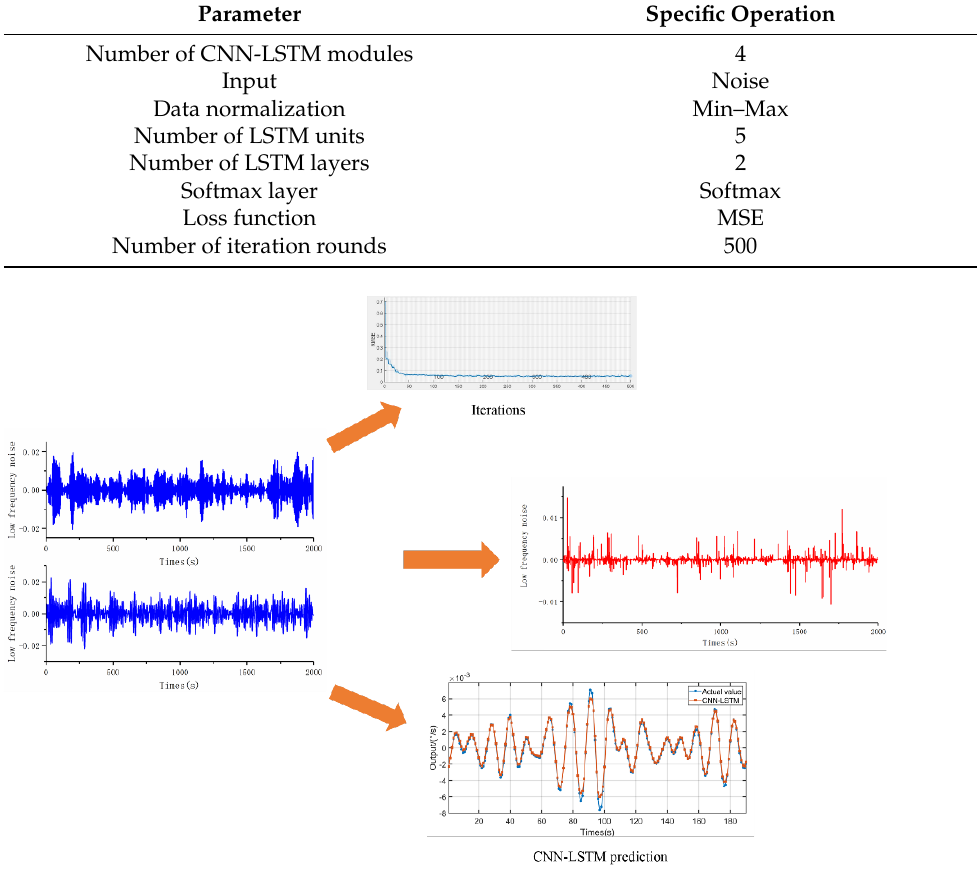
Figure 17. Noise denoising based on CNN-LSTM ( − 40 °C −6 0 °C). Table 1. CNN-LSTM specific operating parameters.